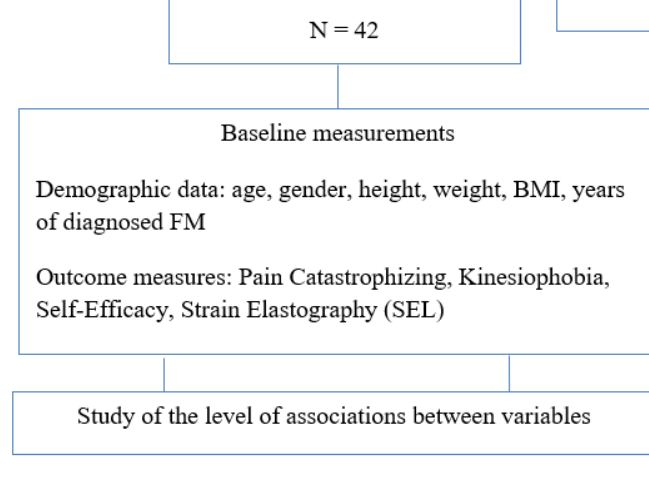
Figure 2. Flow diagram of participants. Level of Association between Psychological Factors and SEL in Painful Points The associations between the Pain Catastrophizing Scale, Tampa Kinesiophobia Scale (TSK-11), Self-Efficacy Scale and strain elastography in the different painful points are presented in Table 2. Table 2. The association between PCS, TSK-11, Self-Efficacy Scale and strain elastography.